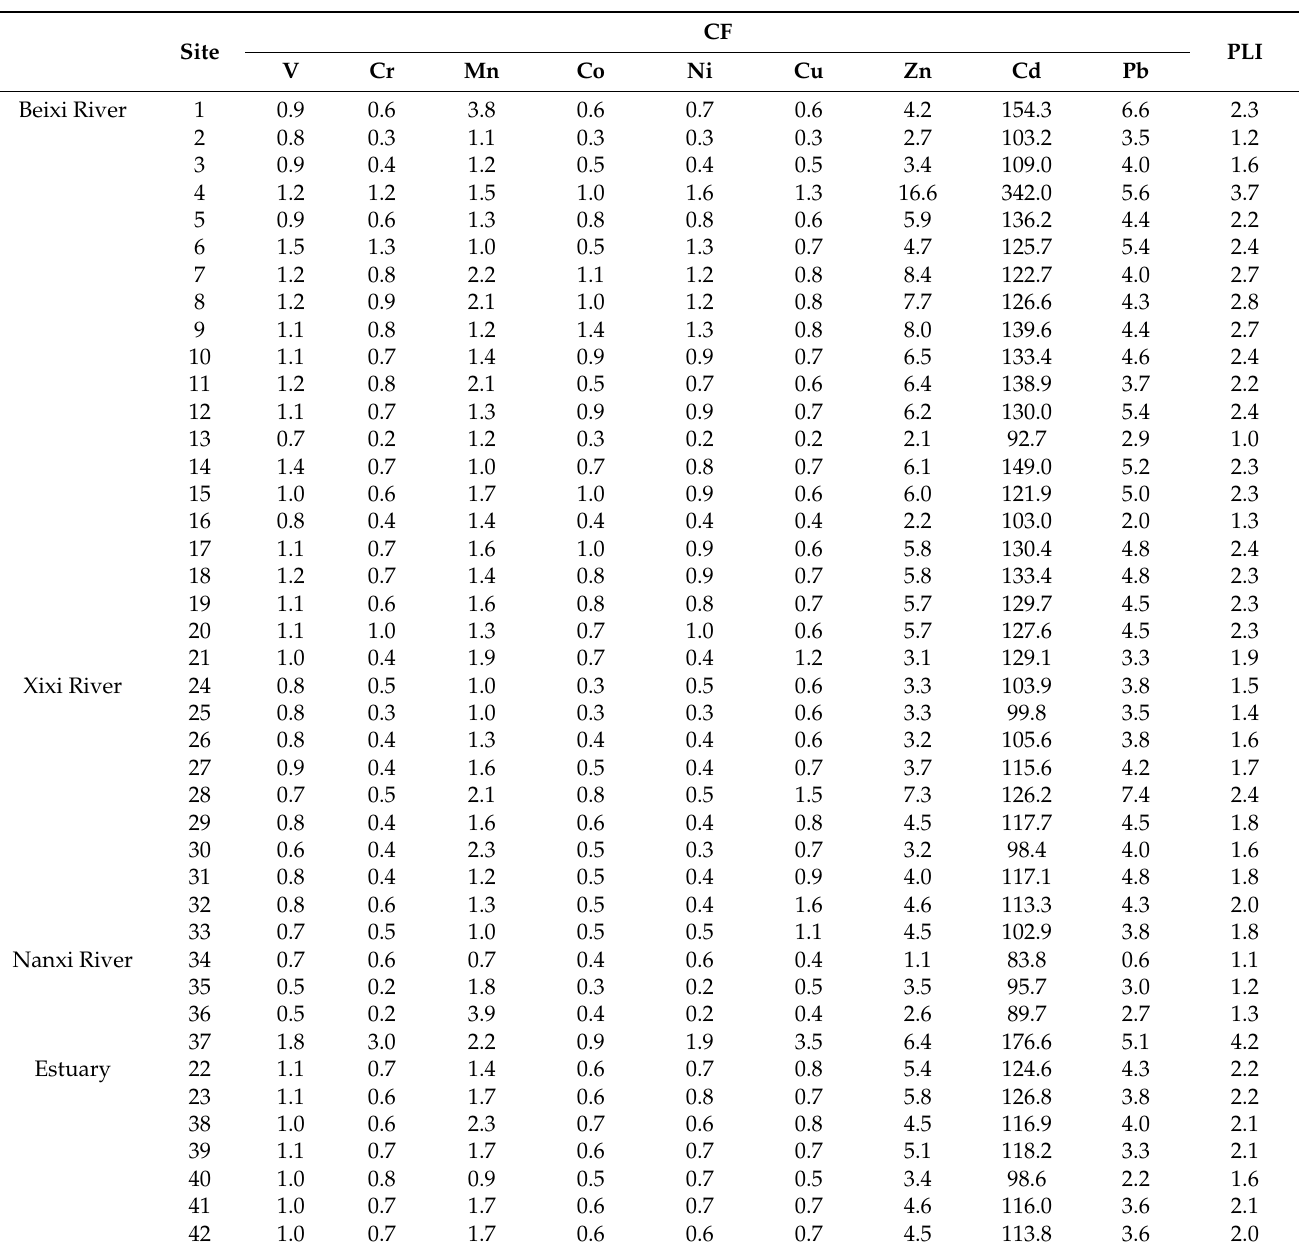
Table 3. The CF and PLI evaluation results of PTEs of the SPM in Jiulongjiang